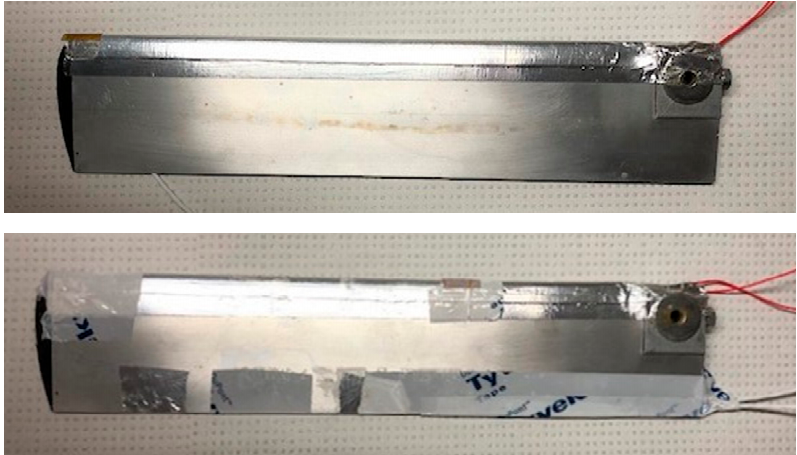
Figure 7. Aluminum blades with heating element and aluminum tape, with and without RTDs.